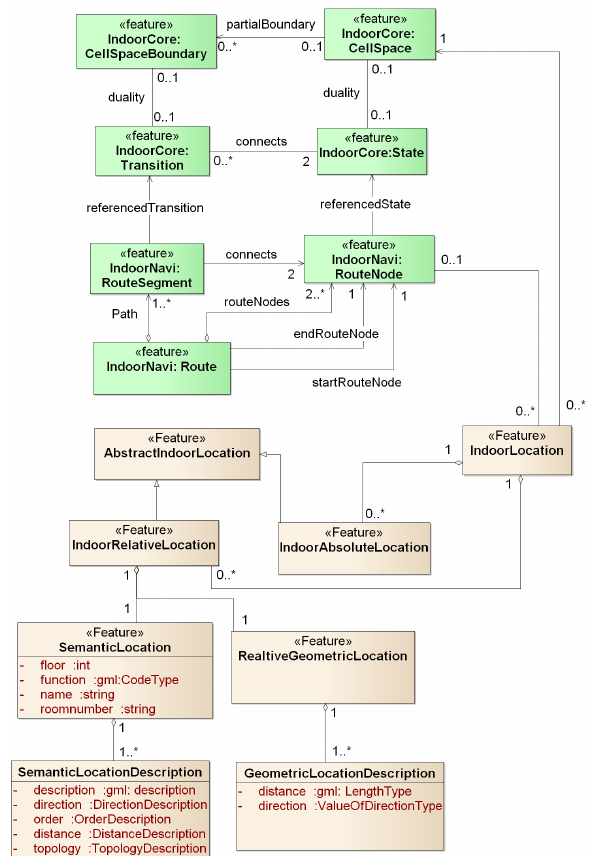
Figure 3. The jointed class diagram of IndoorGML and IndoorLocationGML